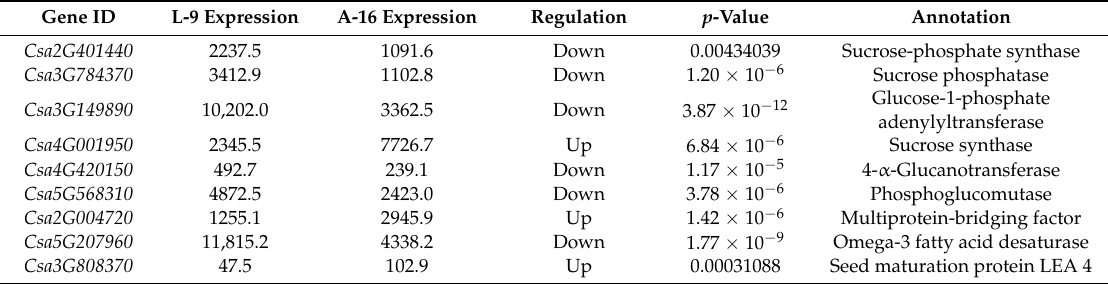
Figure 6. KEGG enrichment of annotated DEGs under three comparisons of normal conditions ( A ) and drought stress ( B ). The y -axis indicates the KEGG pathway and the x -axis indicates the enrichment factor. A high q-value is represented by light blue, and a low q-value is represented by dark blue. Table 2. Genes related to sucrose biosynthesis and response to water